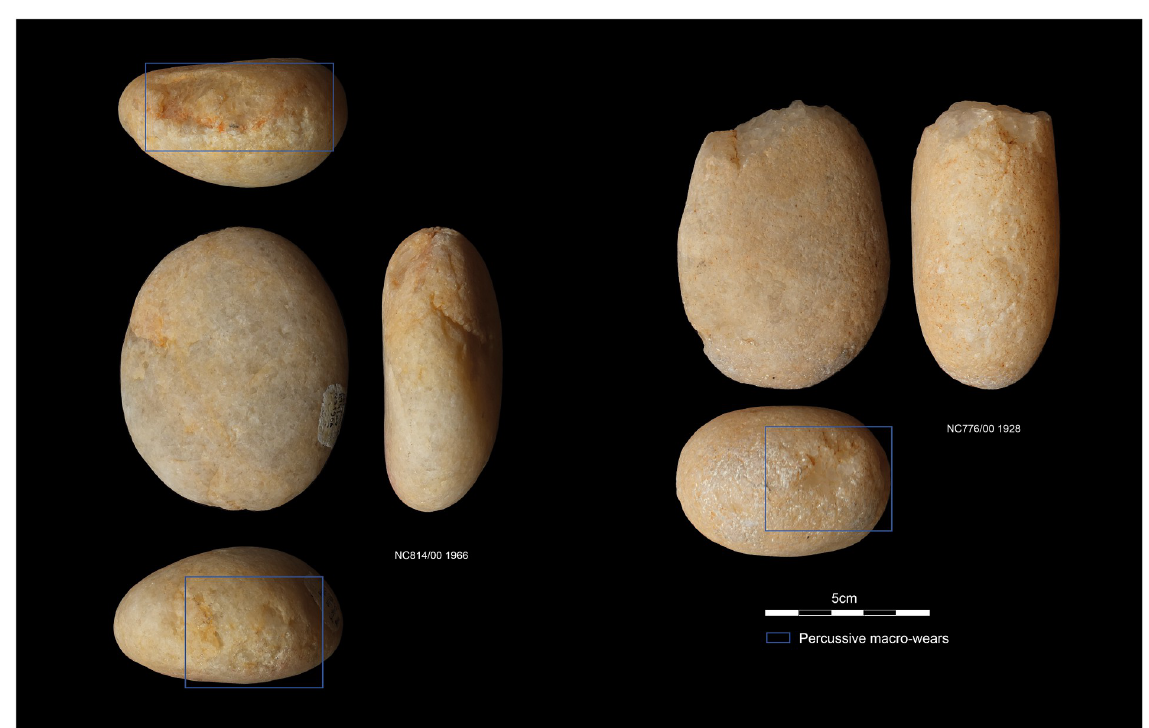
Fig 13. Examples of percussive macro-wear on quartz pebbles from Dungo IV.